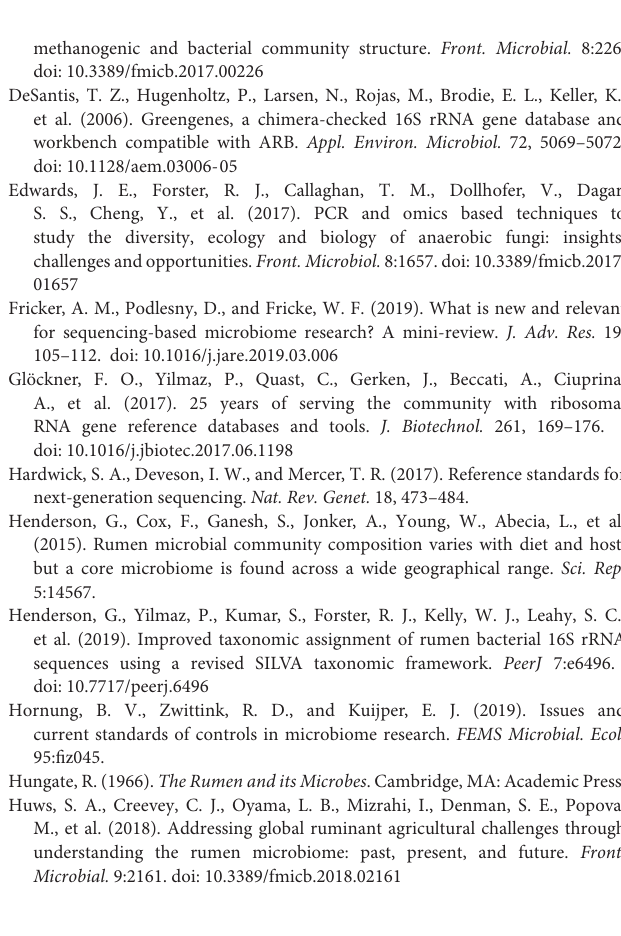
Refseq + RDP database (bootstrap = 80). Supplementary Data 1 | Assign taxonomy script for each